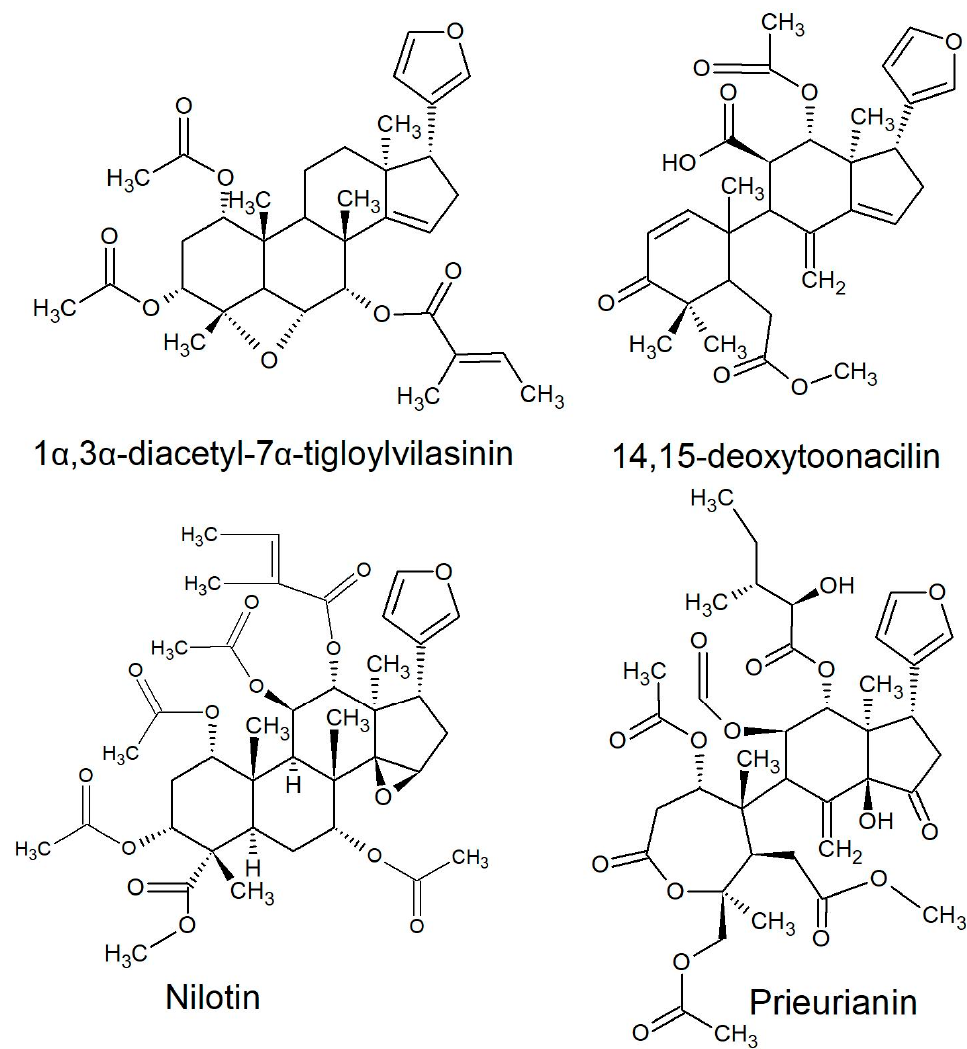
Figure 11. Orphan series of limonoids reported from South African Meliaceae [108,119,121,147].